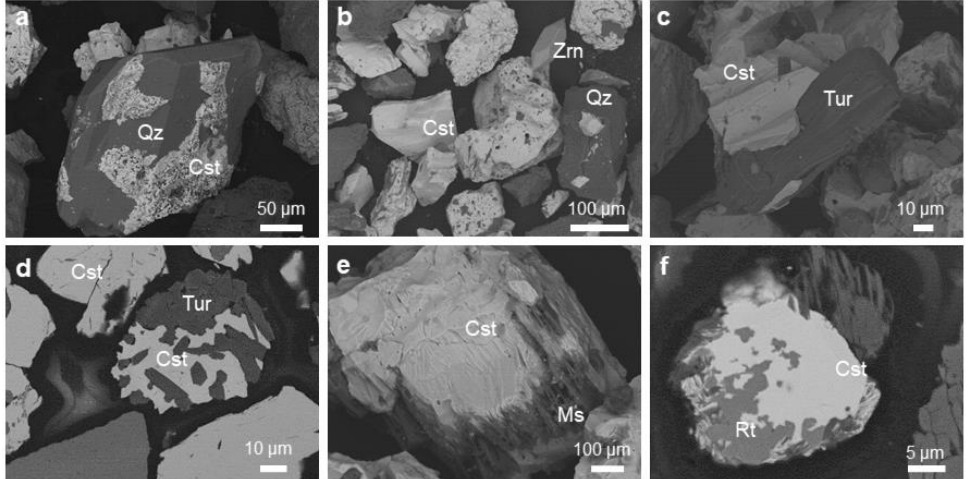
Figure 8. Images of the mineral association of binary particles of cassiterite in the concentrate from Catavi: ( a ) and ( b ) with quartz, ( c ) and ( d ) with tourmaline, ( e ) with muscovite, and ( f ) with rutile. Qz: quartz; Cst: cassiterite; Tur: tourmaline; Ms: muscovite; Rt: rutile.